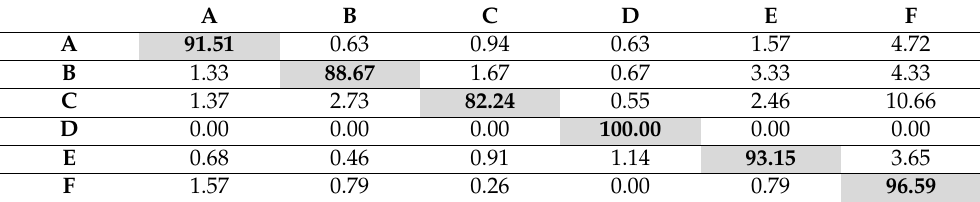
Table 8. Confusion matrix (%) of 3D-DIDGP28 on Set 2 using SVM classifier with RBF kernel function. A B C D